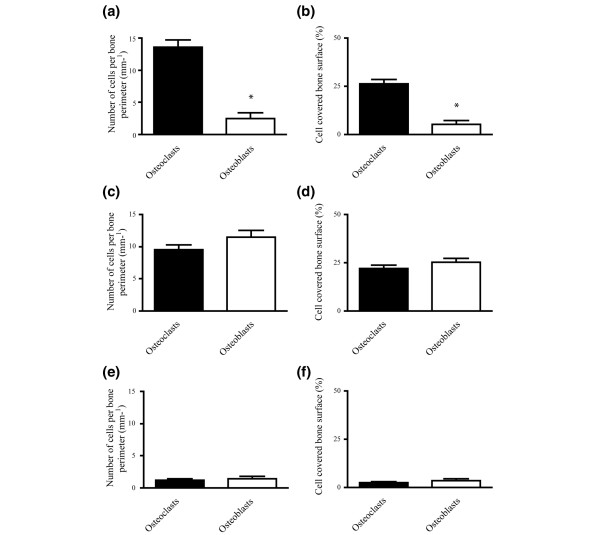
Arthritis induces different patterns of bone turnover in the various compartments of juxta-articular bone. Untreated 12-week-old arthritic mice transgenic for human tumor necrosis factor were evaluated for the numbers (a, c, e) and density (b, d, f) of functional osteoclasts by labeling tartrate-resistant phosphatase and osteoblasts by in-situ hybridization for osteocalcin. Three compartments were analyzed by histomorphometry: (a, b) subchondral bone, (c, d) cortical bone channels and (e, f) the endosteal bone surface distant from inflamed areas. Results are presented as numbers of cells per mm bone surface (a, c, e) and the fraction (%) of bone surface covered by cells (b, d, f). *Statistically significant difference, P < 0.05.